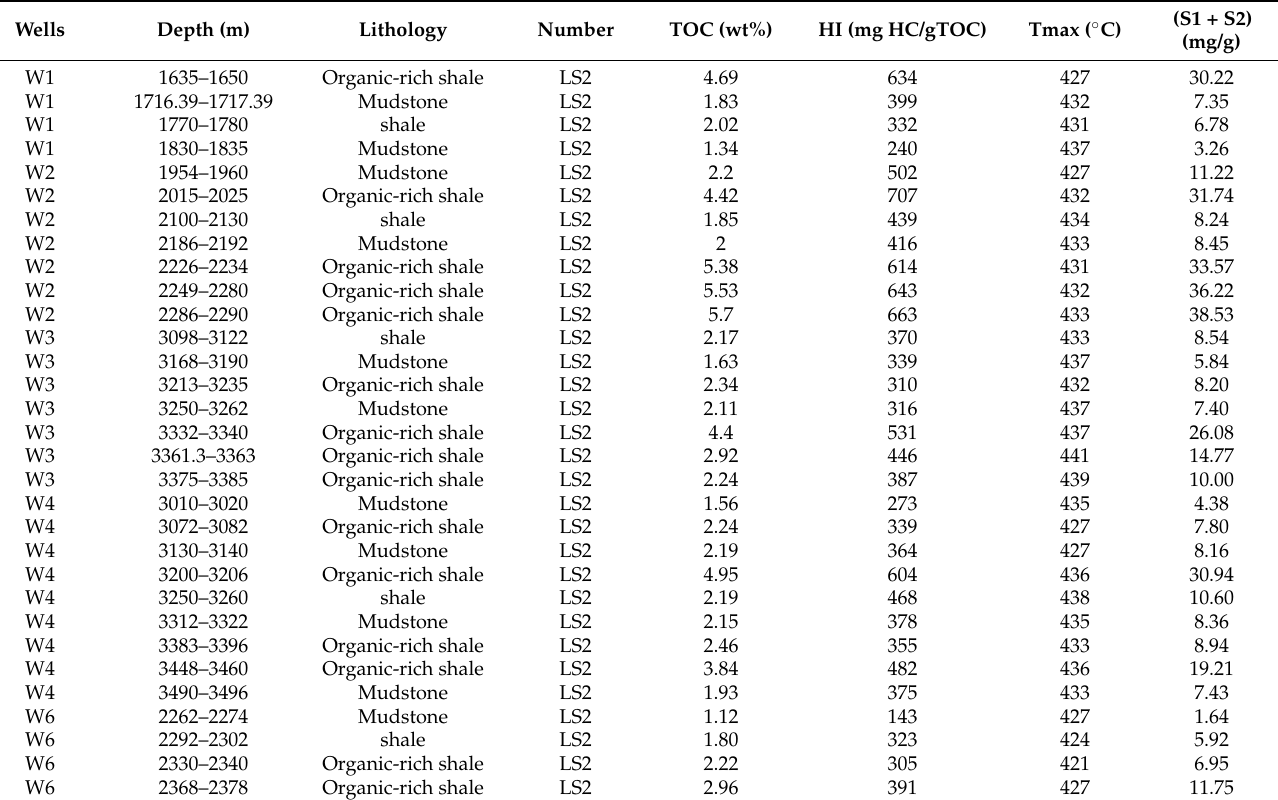
Table 1. Basic geochemical data for source rock samples from LS2 of the Weixinan Sag, Beibuwan